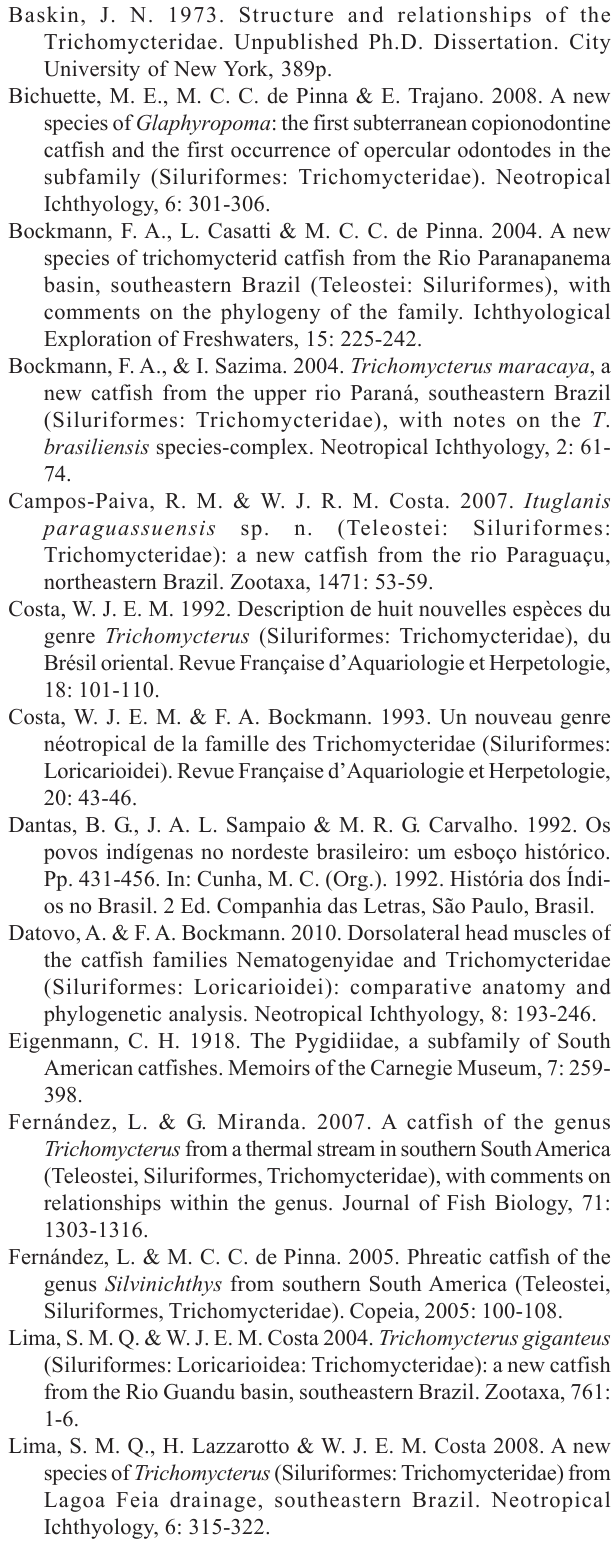
Fria. T . reinhardti : Minas Gerais: MNRJ 17059, 1 (44.5 mm SL), córrego Debaixo da Serra, tributary on the right margin of córrego Água Limpa, tributary on the right margin of córrego das Painas, tributary on the left margin of córrego Beijinho; MNRJ 21416, 2 (50.6-68.7 mm SL), river crossing road MG-030, tributary of